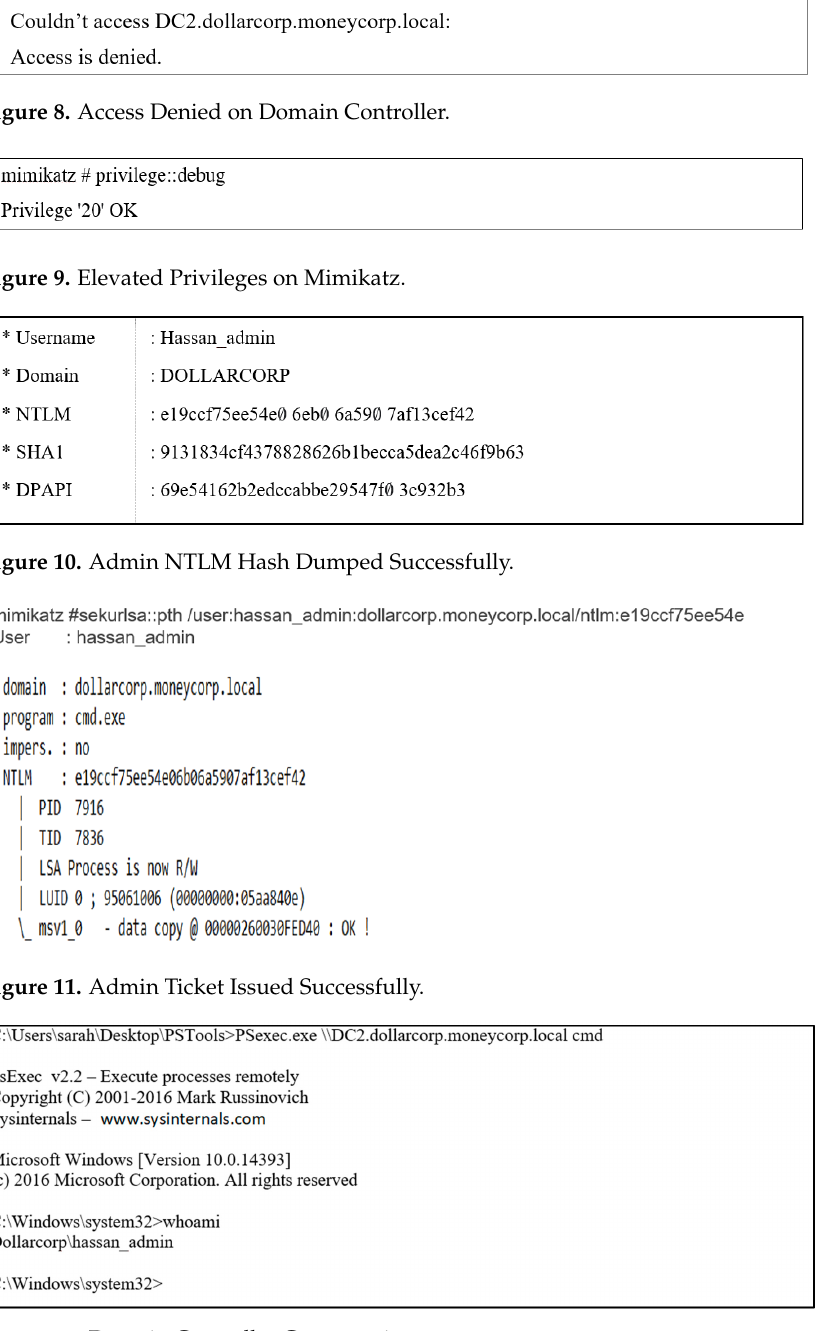
Figure 12. Domain Controller